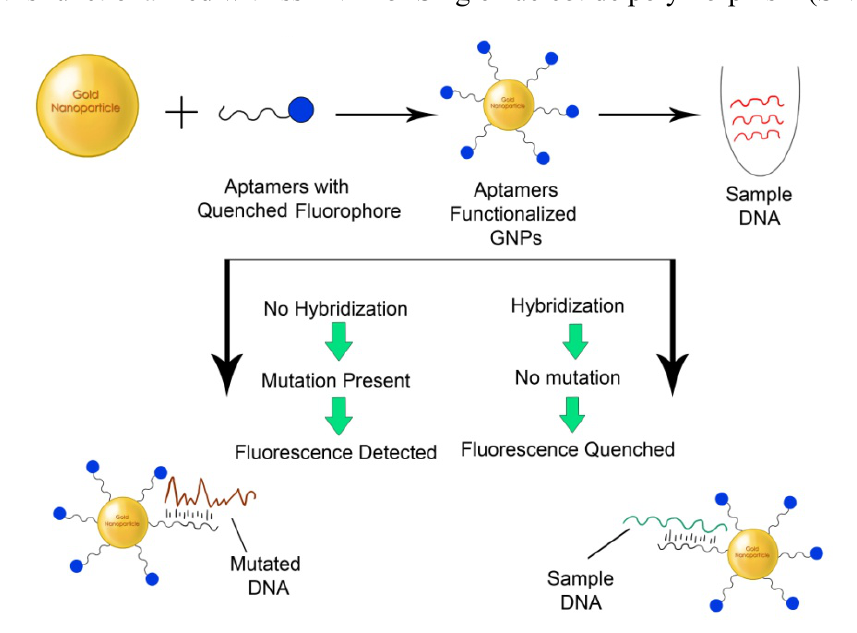
Figure 7. GNPs functionalized with ssDNA for Single nucleotide polymorphism (SNP)